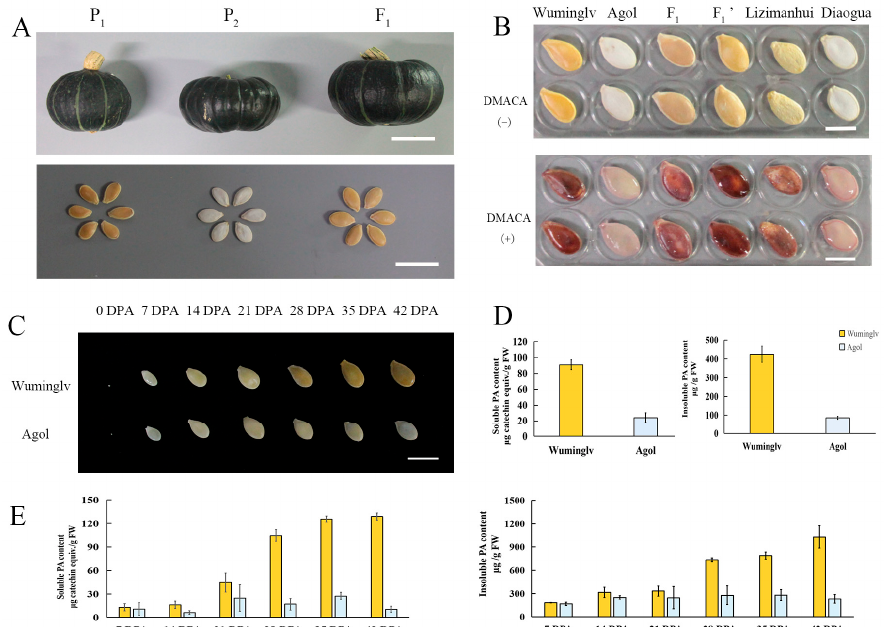
Figure 1. The phenotype of seed coat color and pigment accumulation in Cucurbita maxima. ( A ) Fruit and seed coat color in Wuminglv and Agol. The upper bar = 5 cm, the lower bar = 2 cm. ( B ) DMACA staining in Wuminglv (P 1 ), Agol (P 2 ), F 1 , F 1 (cid:48) , Lizimanhui (P 3 ), and Diaogua (P 4 ). Bar = 2 cm. ( C ) Seed coat color formation during the seed development at different stage after pollination. Dynamic changes of seed coat color at 0, 7, 14, 21, 28, 35, 42 DPA (days post anthesis). Bar = 2 cm. ( D ) Soluble and insoluble PA determination of mature dry seeds in Wuminglv and Agol. ( E ) Soluble and insoluble PA determination of flesh seeds at 7, 14, 21, 28, 35, 42 DPA in Wuminglv and